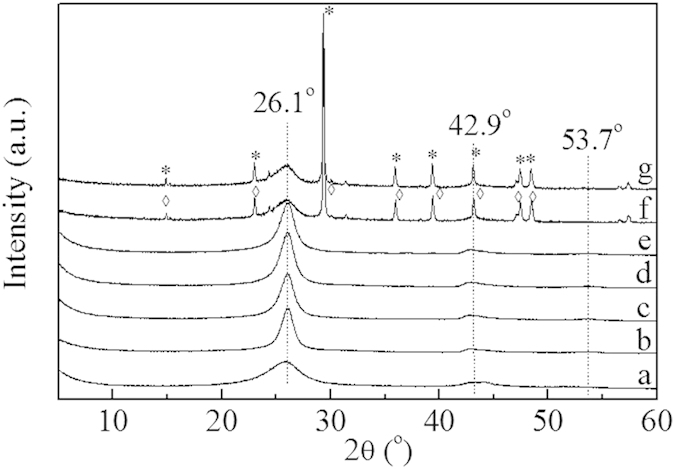
XRD patterns of (a–e) fresh and (f,g) spent catalysts: (a) Ru/AC; (b) Ru/CNTs-in; (c) Ru/CNTs-out; (d) Ru/CNTs; (e) RuWOx/CNTs; (f) Ru/CNTs-used and (g) RuWOx/CNTs-used.